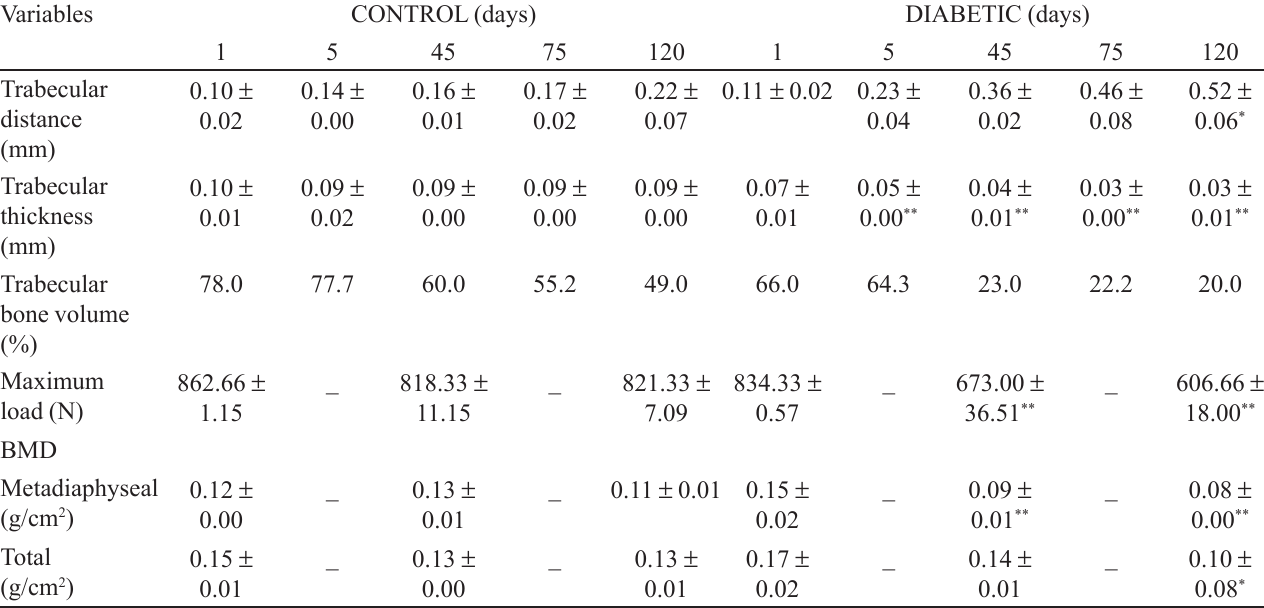
TABLE II - Histomorphometry measurements, biomechanical testing and bone mineral density in femoral of premenopausal Wistar rats